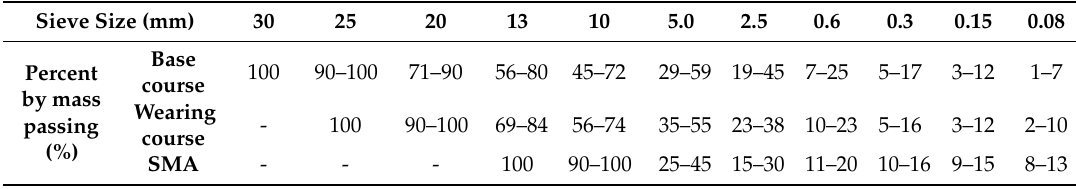
Table 1. Aggregate gradation of asphalt.